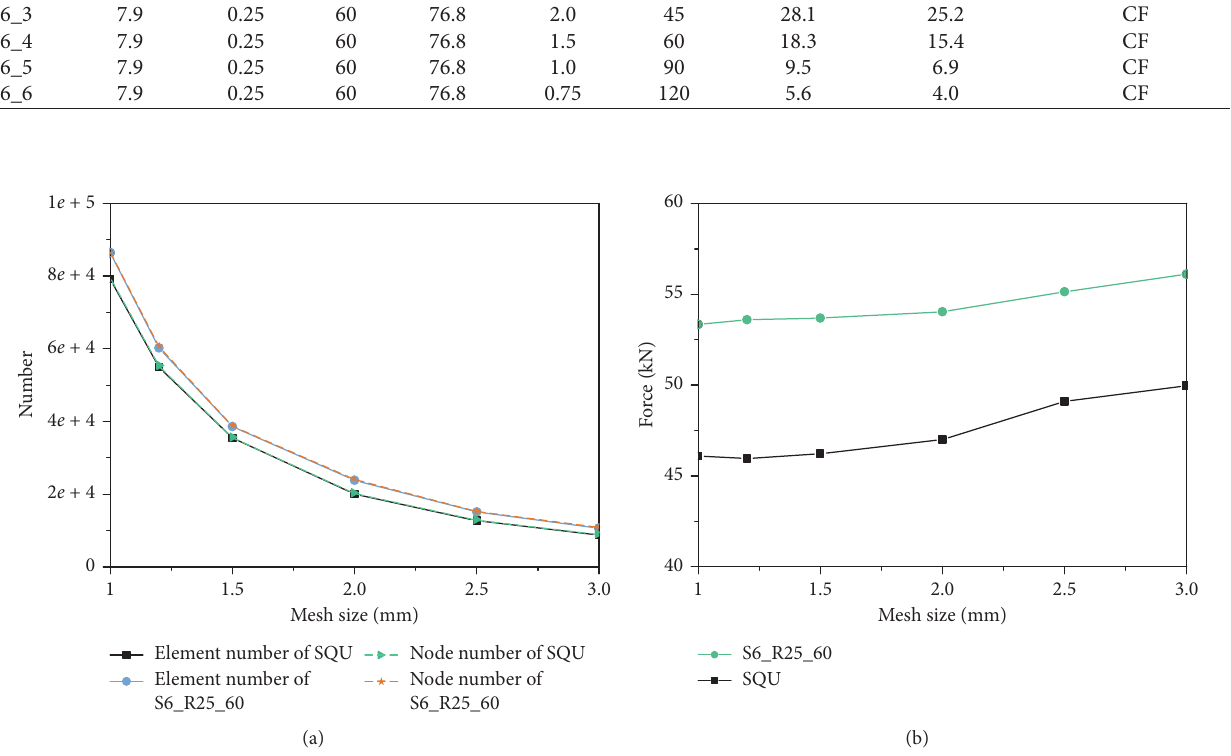
Figure 5: (a) Number of elements and nodes and (b) force convergence for two representative tubes with six mesh